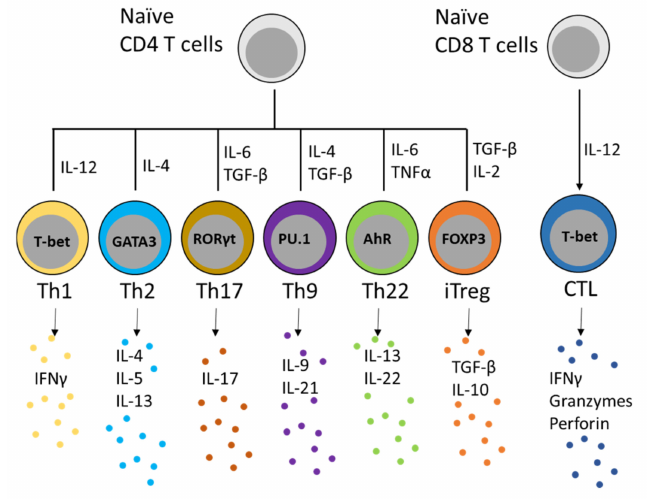
Figure 2. Activation of CD4+ naïve helper T cells by antigen stimulation and cytokine signaling promotes their differentiation into multiple effector subsets, which is developmentally controlled by the master transcription factors as indicated. These CD4+ T helper subsets include: Th1 driven by IL-12 and T-bet; Th2 by IL-4 and GATA3; Th17 by IL-6, TGF- β and ROR γ t; Th9 by IL-4, TGF- β and PU.1; Th22 by IL-6, TNF α and AhR (Aryl hydrocarbon receptor); and iTreg by TGF- β , IL-2 and FOXP3. For CD8+ T cytotoxic cells, IL-12 and T-bet play an important role in inducing their differentiate into CTL (cytotoxic T lymphocytes). For some cases, it should be noted that under physiological conditions, the cells that produce the cytokines to mediate effector T cells differentiation are still not clearly defined. The master transcription factor(s) for each T cell effector subset defines their transcriptional program and promotes the expression of the signature effector cytokines (as indicated below each T cell subset) to control the host immune responses to pathogenic and malignant